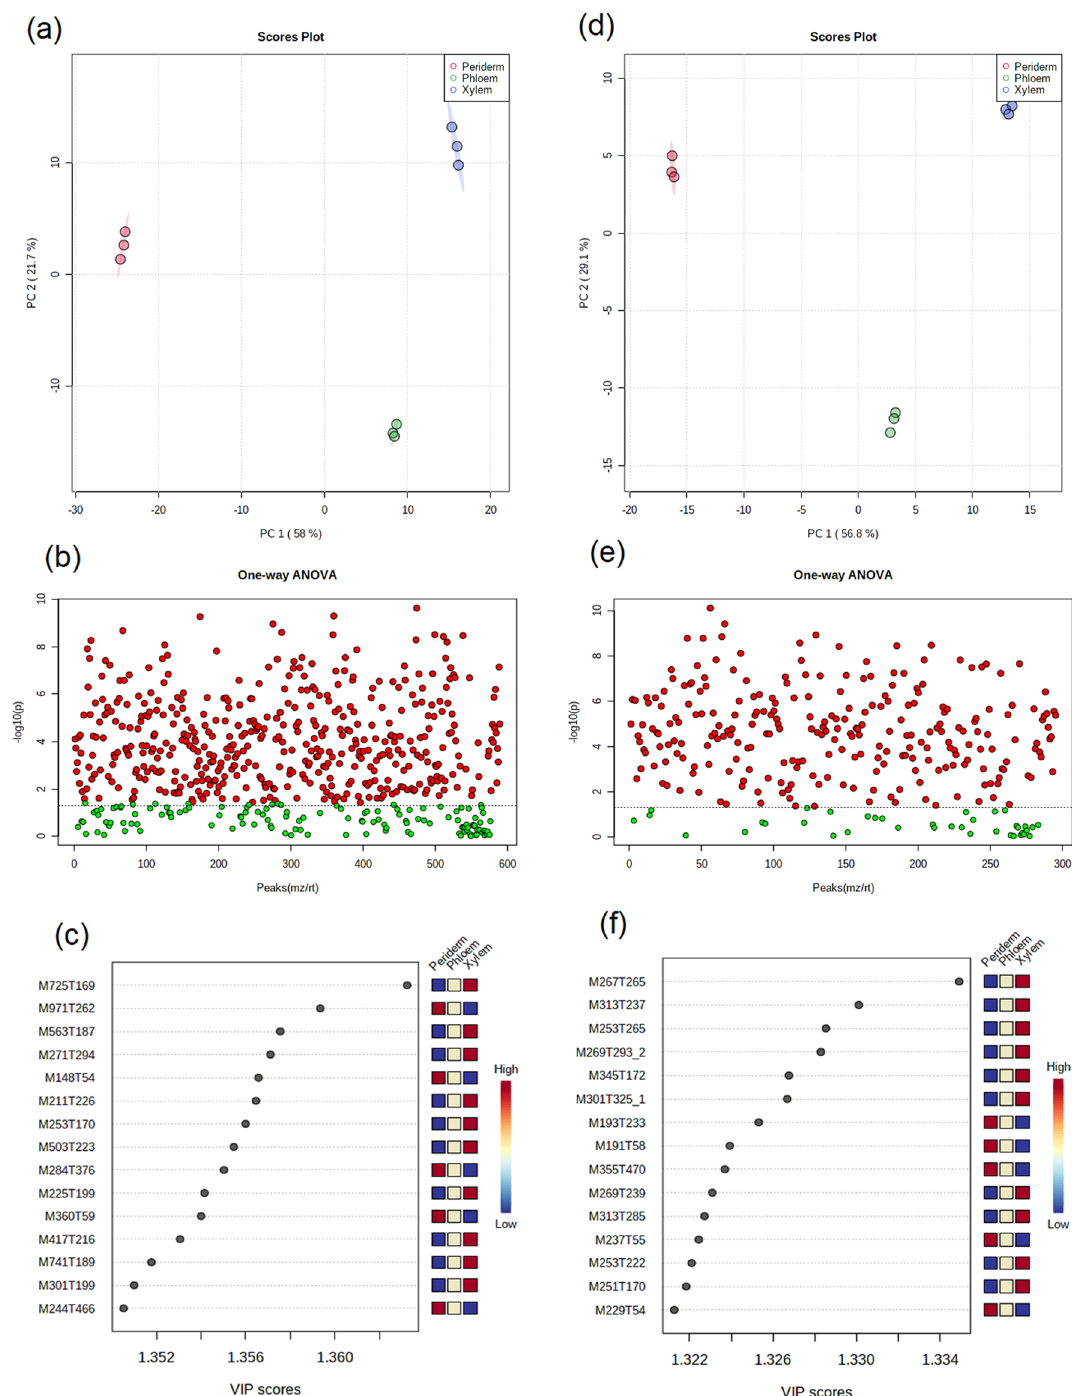
Figure 1. Metabolomic analysis of the components in the root tissues of S. flavescens . ( a ) PCA score plots of positive ion mode. ( b ) One-way ANOVA of the positive ion mode. ( c ) Variable importance in the projection of positive ion mode. ( d ) PCA score plots of negative ion mode. ( e ) One-way ANOVA of negative ion mode. ( f ) Variable importance in the projection of negative ion